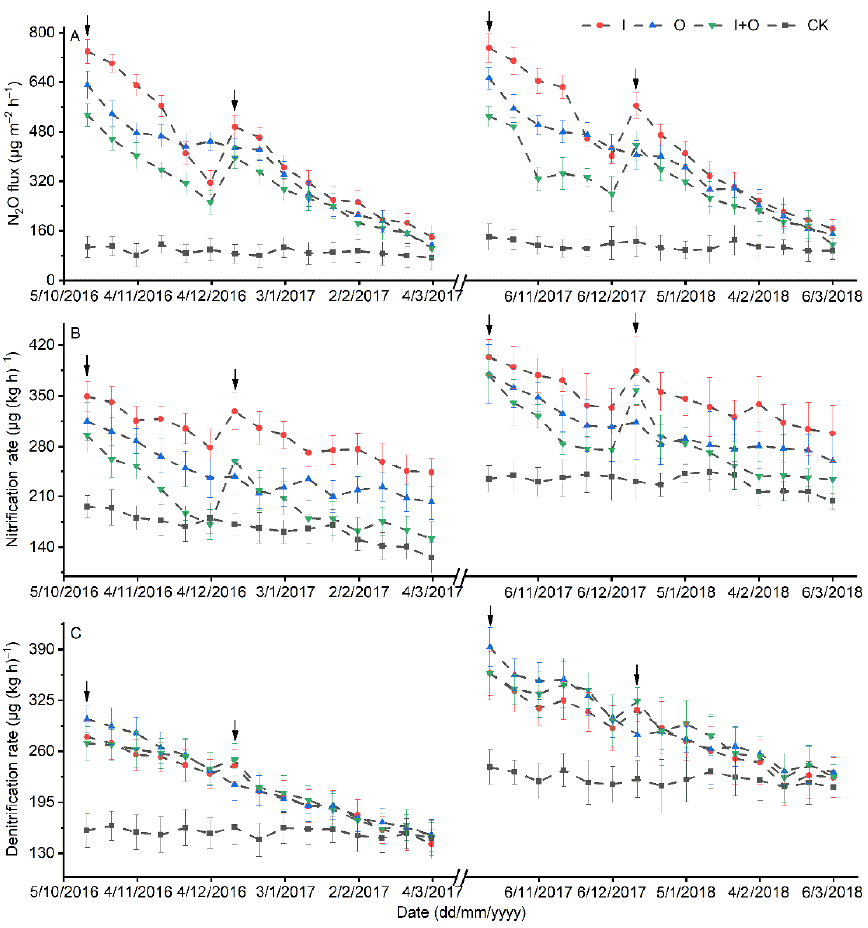
Figure 3. The N 2 O fluxes ( A ), gross rates of nitrification ( B ) and denitrification ( C ) in soil under different treatments throughout two growing seasons of purple caitai. Arrows indicate N fertiliza- tion. I, inorganic N fertilization; O, organic N fertilization; I+O, integrated organic/inorganic N fer- tilization; CK, no fertilization.